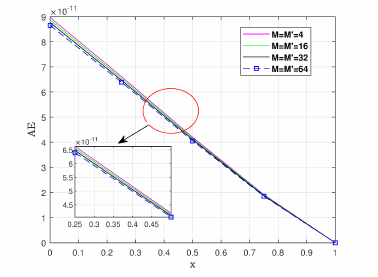
Figure 8. The comparison between the exact and the approximate solutions with and m = m ′ = 1, η = η 1 = 1 and different 2 2 values of M = M ′ for Example 2.